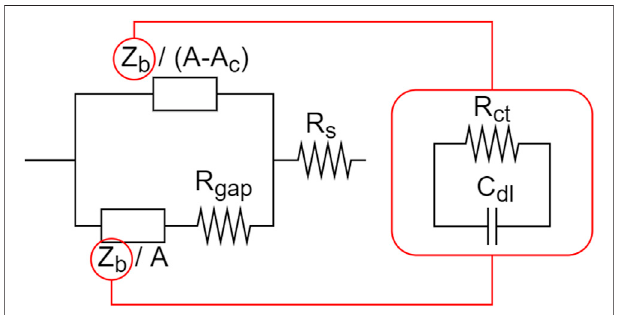
FIGURE 2 | Circuit model for an electrode of area A. Electrode area is partially covered (Ac) with cells. Impedance Zb represents the contributions of